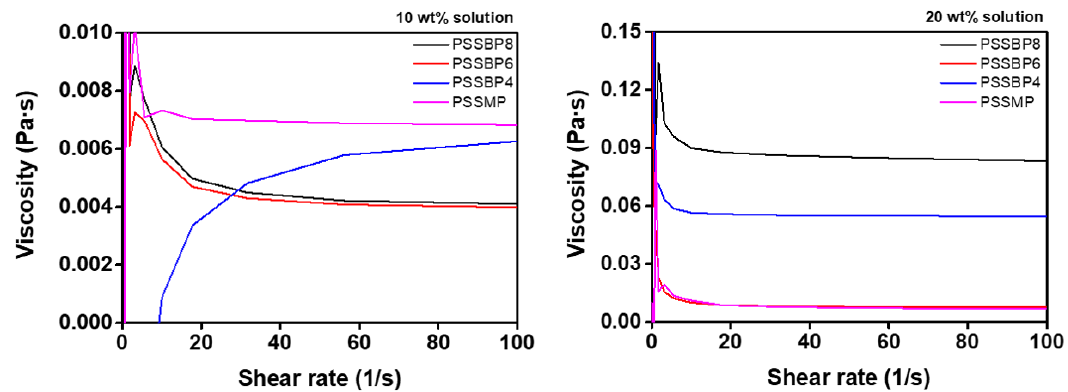
Figure 4. Viscosity of PSSBP# series and PSSMP according to shear rate at room temperature.